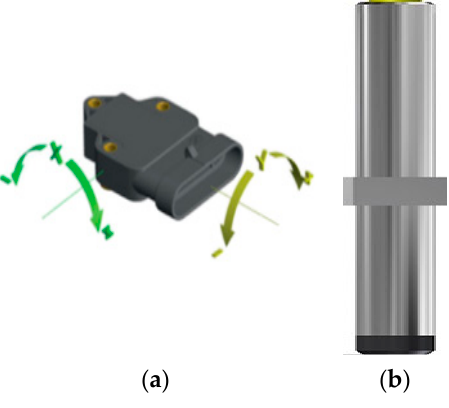
Figure 6. SHM ‐ ASSP ZRC Nodes. ( a ) SSN. ( b ) CSN. Figure 6. SHM-ASSP ZRC Nodes. ( a ) SSN. ( b ) CSN.